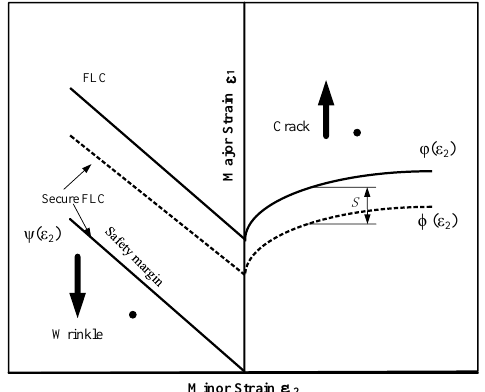
Figure 3. Definition diagram of cracking and wrinkling quantification criteria. Φ ( ε 2 ) is the safety marginal curve, ψ ( ε 2 ) is the wrinkle limit curve, and ϕ ( ε 2 ) is the FLC.